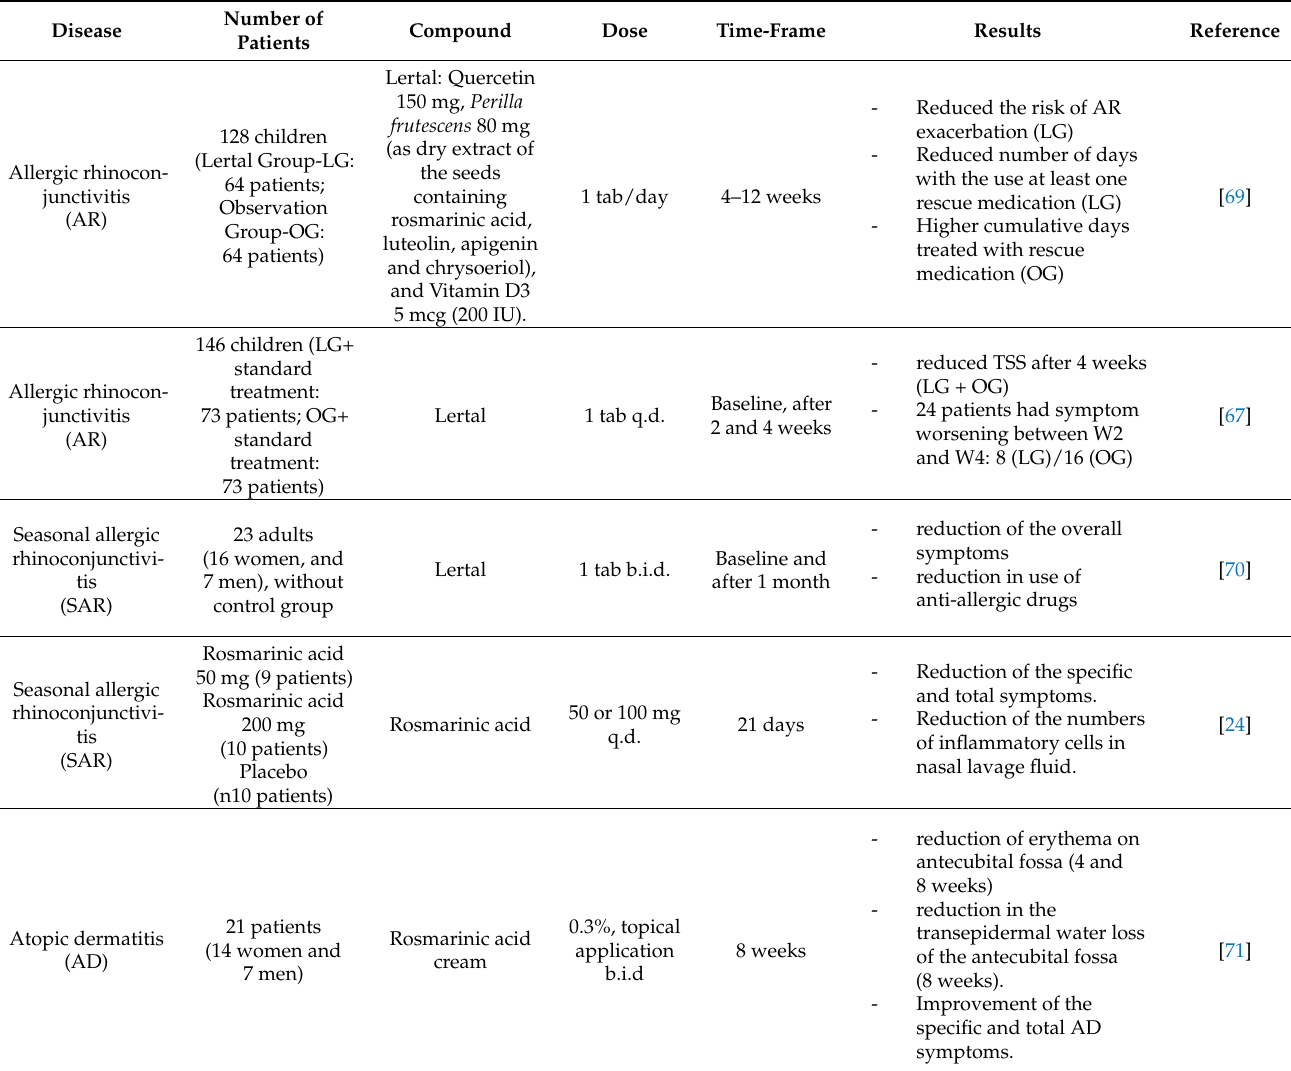
Table 2. Summary of evidence from studies performed in human subjects regarding the Perilla frutescens anti-inflammatory and antiallergic